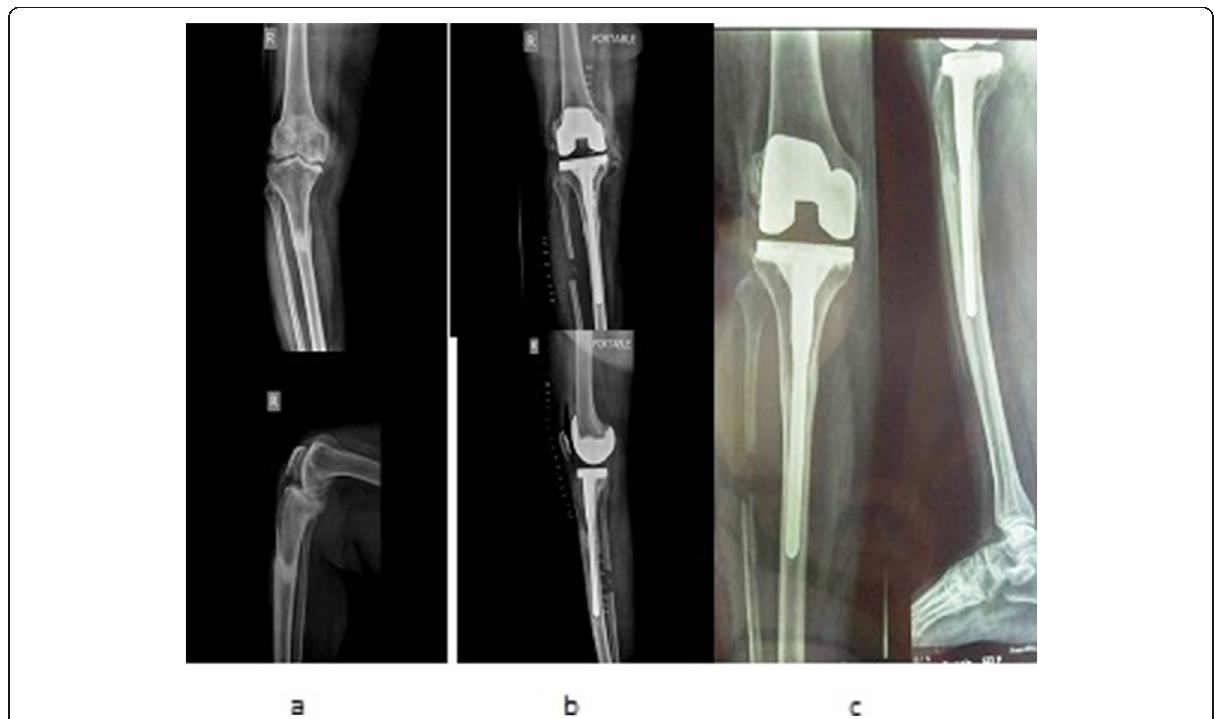
Fig. 4 Right Knee X-rays. a ) Preoperative anteroposterior and lateral view showing features suggestive of osteoarthritis, with deformity with stress fracture proximal tibia; b ) Postoperative X-ray anteroposterior and lateral view showing correction of deformity with modular stemmed knee prosthesis with proximal fibular resection; c ) Recent follow-up anteroposterior and lateral view showing healed stress fracture with correction